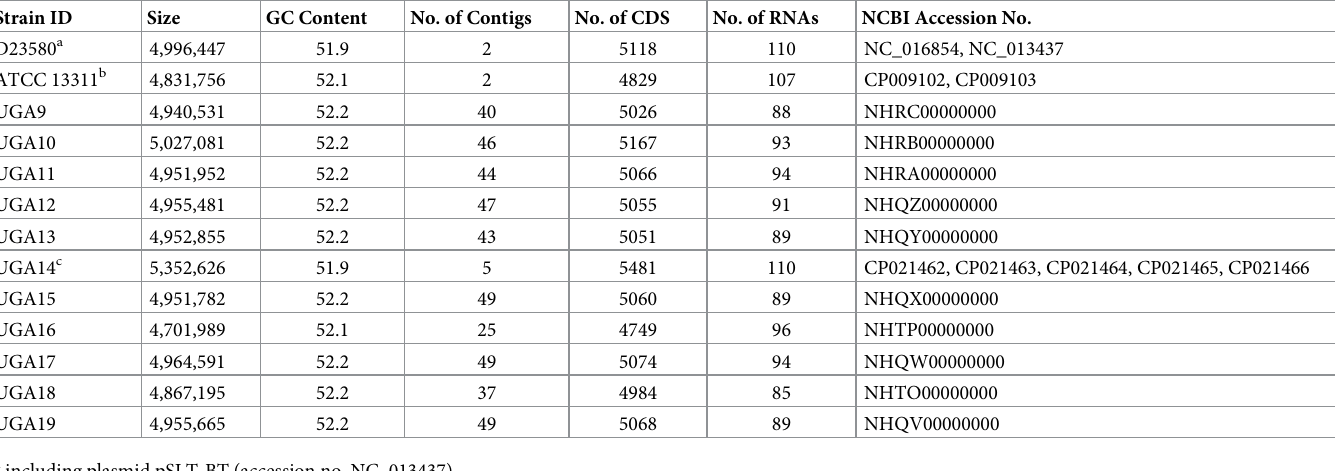
Table 2. Whole genome sequencing